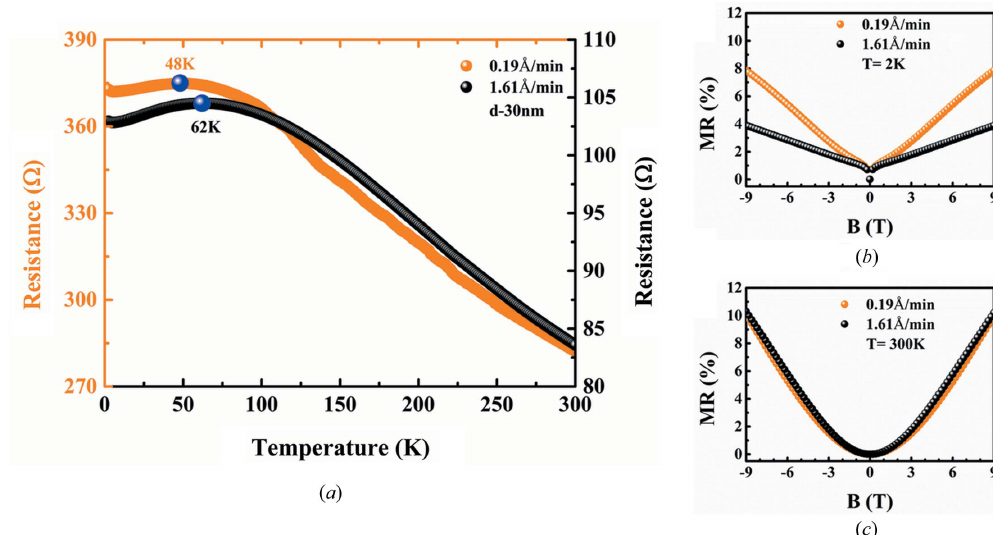
Figure 12 ( a ) Growth-rate dependence for resistance of Bi thin films (30 nm) at 0.19 and 1.61 A˚ min (cid:5) 1 . Blue spheres indicate the transition temperature points T top . ( b ) Normalized MR as a function of magnetic field B = (cid:5) 9 T – 9 T at T = 2 K, comparing growth rate at 0.19 and 1.61 A˚ min (cid:5) 1 . Here MR = [ R ( B ) (cid:5) R (0)]/ R (0) (cid:4) 100, where R ( B ) and R (0) are the resistance with and without the magnetic field B , respectively. ( c ) Normalized MR as a function of magnetic field B = (cid:5) 9 T – 9 T at T = 300 K, comparing growth rate at 0.19 and 1.61 A˚ min (cid:5) 1